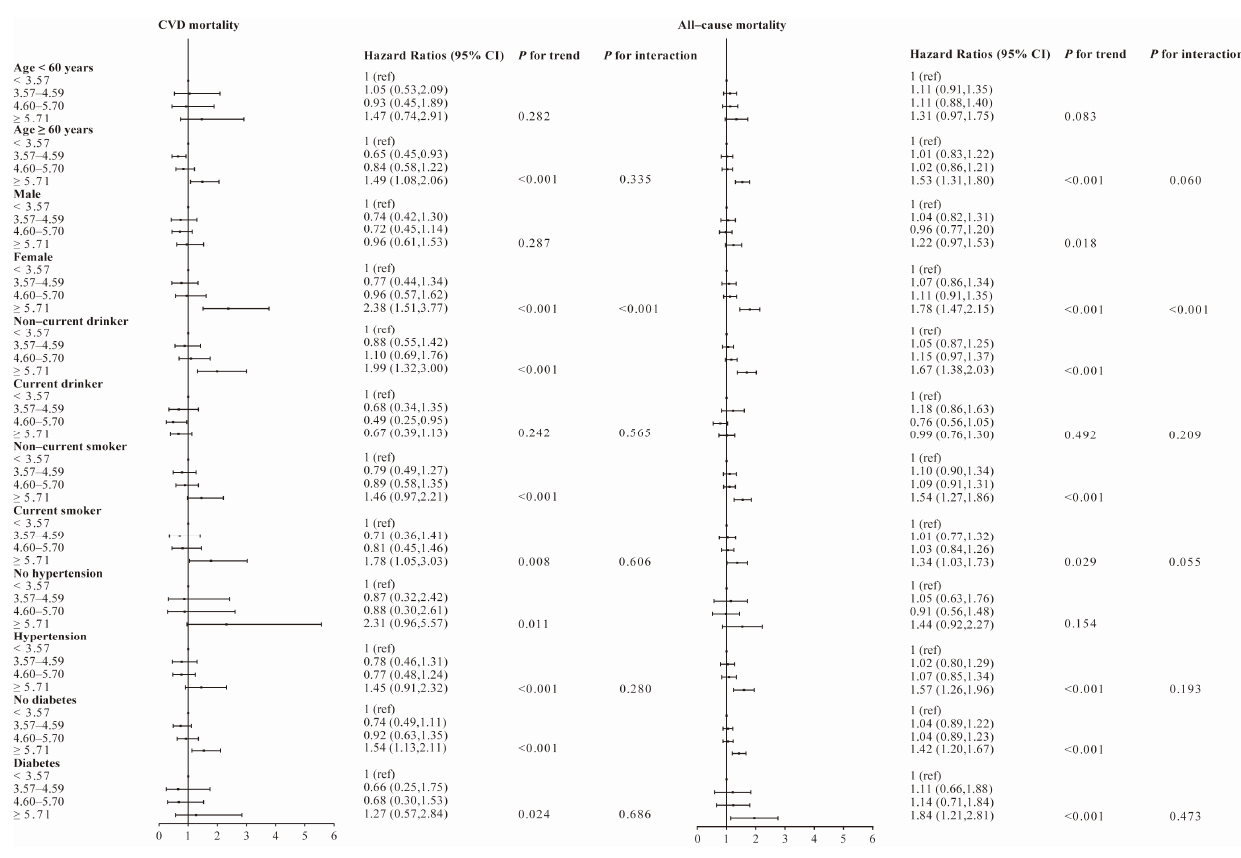
Figure 2. Associations between blood urea nitrogen and CVD, all-cause mortality stratified by age, gender, alcohol drinking status, smoking status, history of hypertension, history of diabetes. Hazard ratios were adjusted for age, sex, race/ethnicity, education, BMI, alcohol drinking status, smoking status, total cholesterol, ALT, total protein, albumin, globulin, HDL, history of hypertension and history of diabetes.